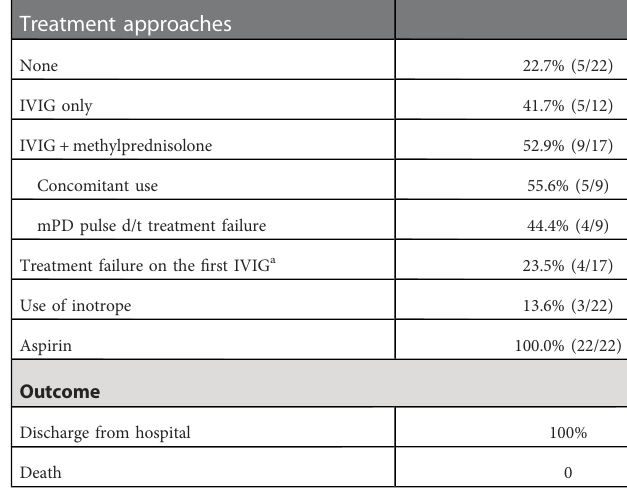
TABLE 6 Treatment approaches and outcomes in patients with MIS-C.